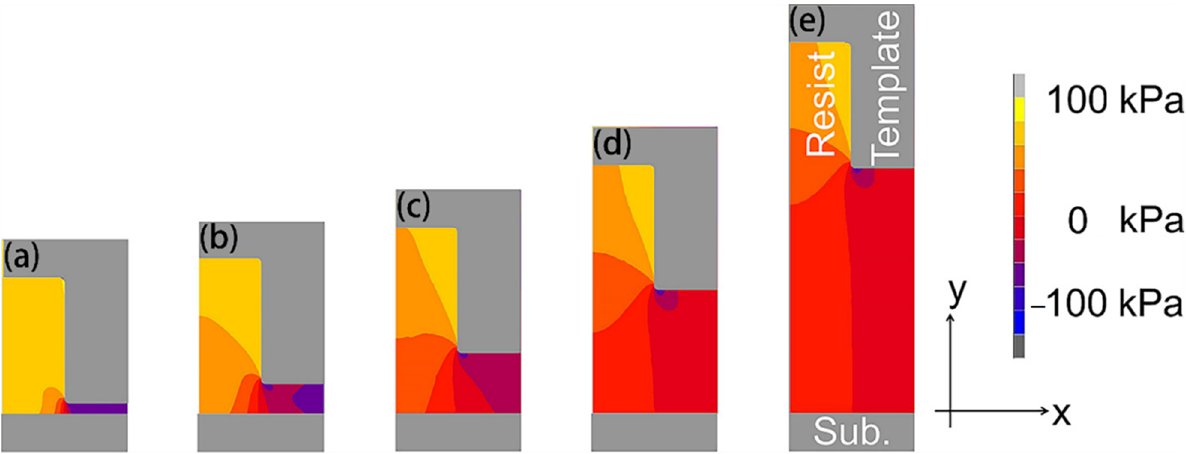
Figure 4. Residual stress σ yy distribution for various residual thicknesses after 0.5% shrinkage, with the resist fully adhering to the template, where the residual thicknesses are ( a ) 10, ( b ) 25, ( c ) 50, ( d )100, and ( e ) 200 nm. Reprinted with permission from [54]. Copyright 2014 American Vacuum Society.